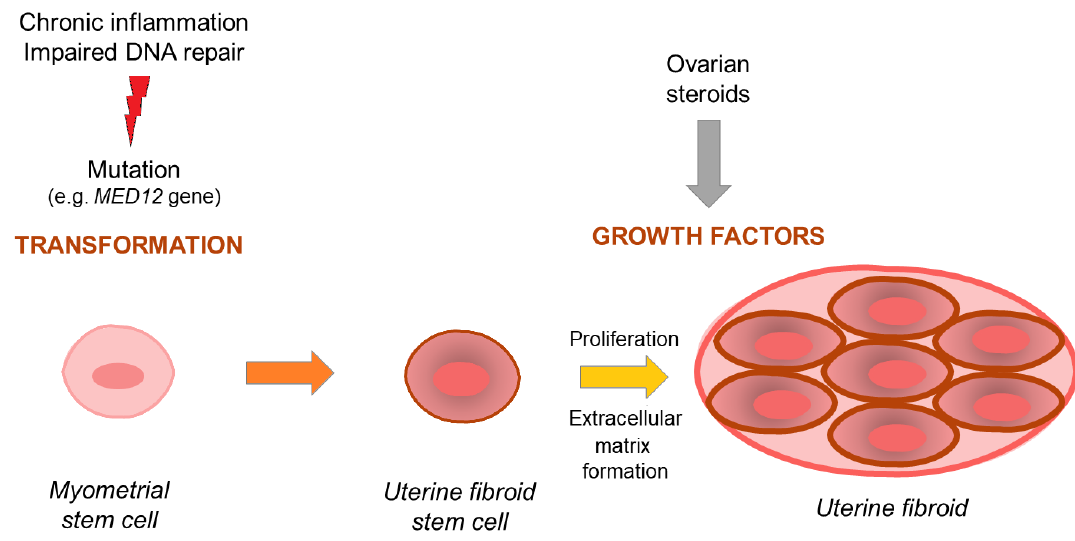
Figure1. Developmentandgrowthofuterinefibroid—simplifiedscheme. Importanceofmutation-derived Figure 1. Development and growth of uterine fibroid—simplified scheme. Importance of mutation- transformation and stimulation of hormones and growth derived transformation and stimulation of hormones and growth factors.